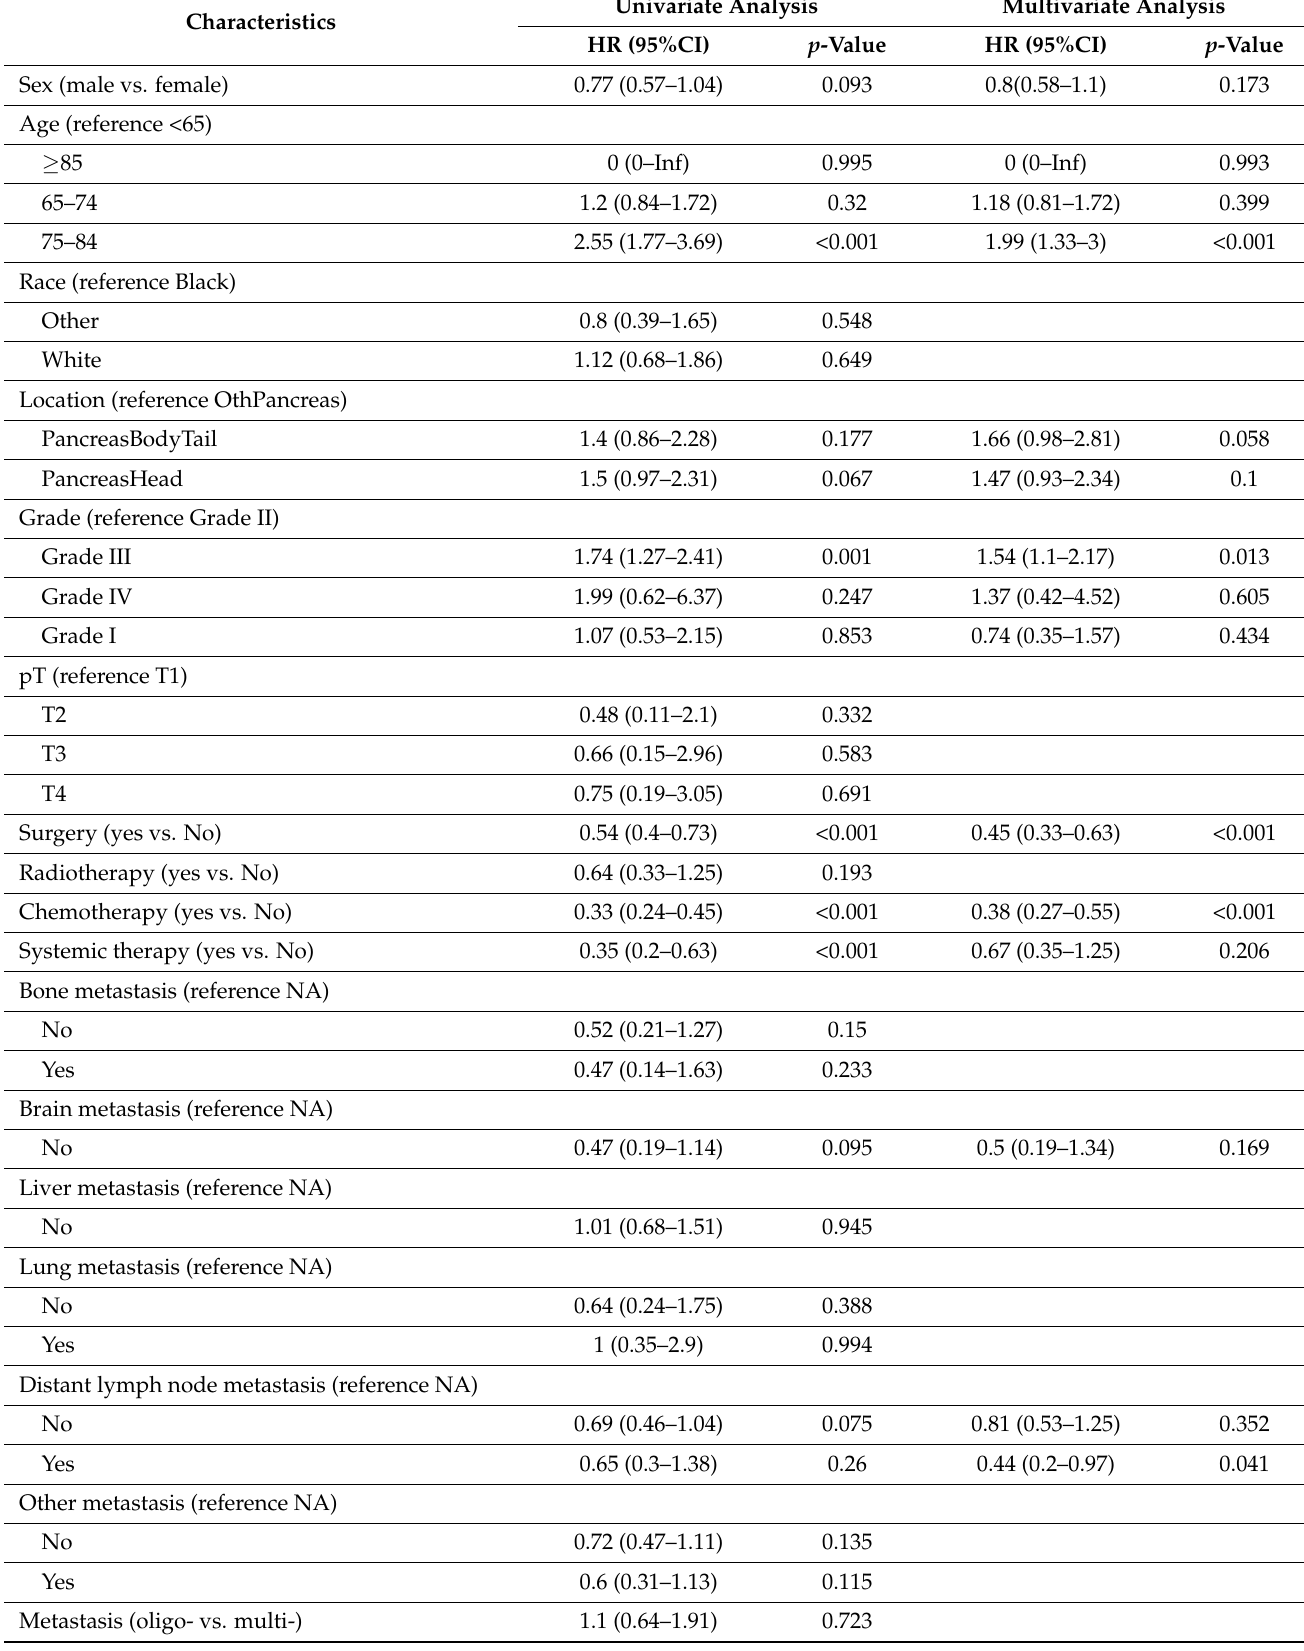
Table 4. Cox regression analysis of cancer-specific